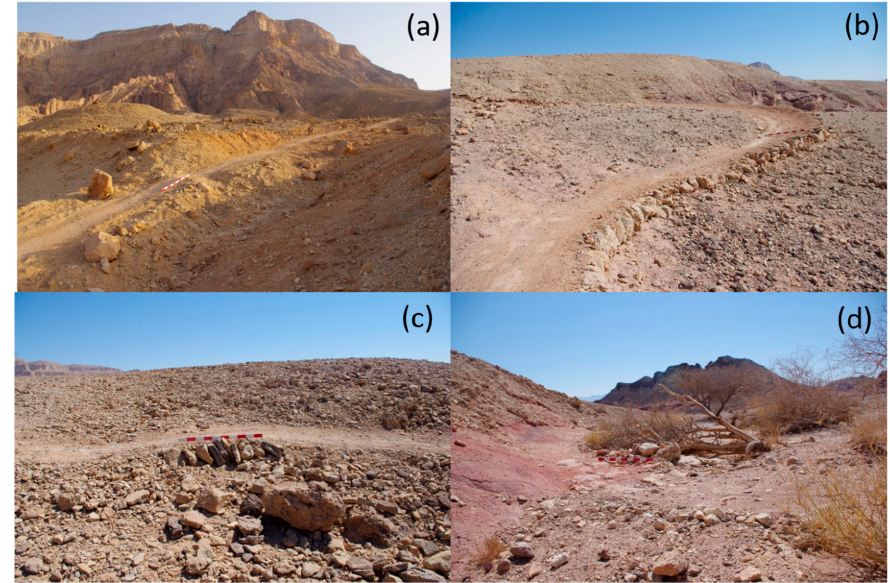
Figure 7. Pictures taken (by the manuscript’s first author) in Timna Park, southern Israel, demonstrate: ( a ) a spillway cutting the longitudinal connectivity of a singletrack. Note the shallow bump downtrack of the spillway, aimed at completely halting hydrological connectivity down the track. Also, note the stones spread downhill of spillway, aimed at dissipating flow energy and preventing gully incision; ( b ) downhill curving singletrack. Curve is constructed with a soil-filled berm and strengthened with a stone terrace. Note the ‘cemented’ track surface, and the berm’s counter-slope in the upper curve; ( c ) the ‘library’ structure, made of vertically-positioned elongated stones, wedged in the soil is effective in forming high and yet stable terraces; and ( d ) an ephemeral stream channel crossing point. Note the large flat rocks ‘paving’ the channel floor, aimed at preventing the bike tires’ from trenching the bed’s stone fill. The rocks positioned upstream of the crossing site dissipate flash floods’ energy, and the loose rock check dam downstream of the crossing site negates gully incision.